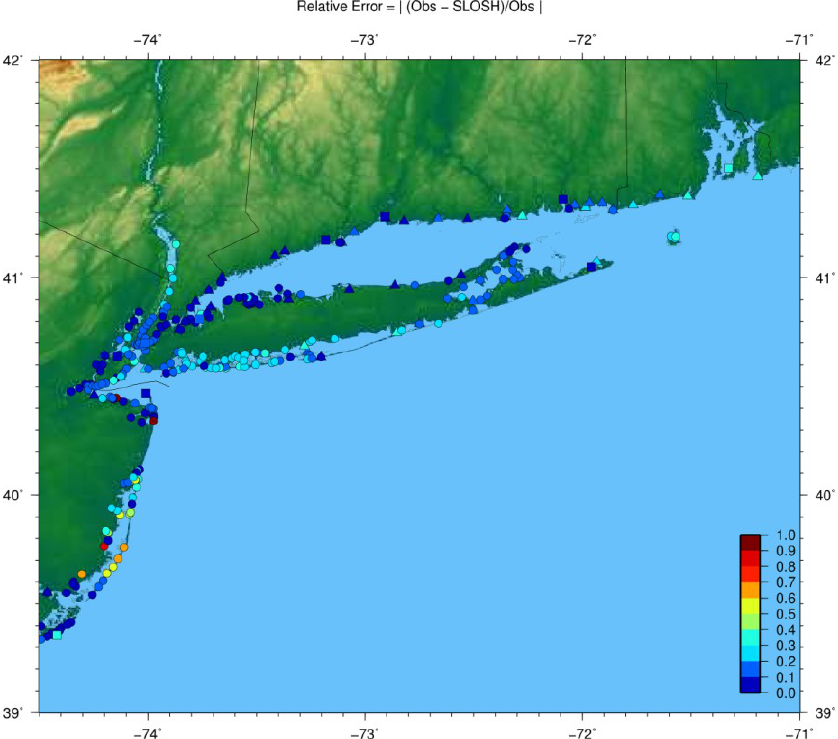
Figure 17. Geographical distribution of the relative error between the observed and SLOSH-simulated maximum water